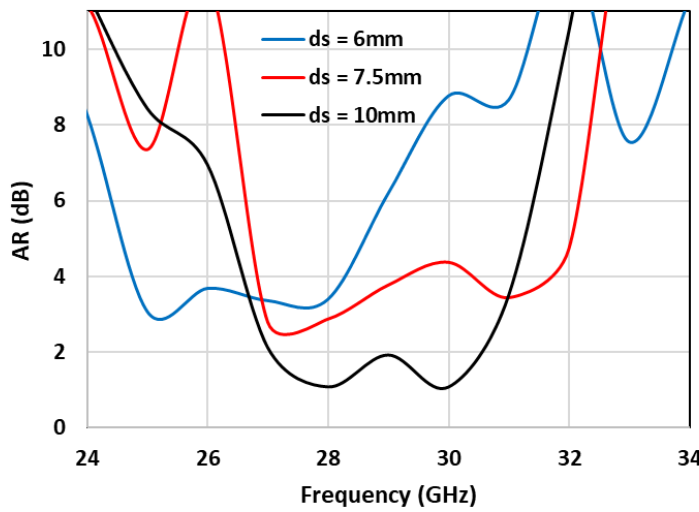
Figure 8. Axial ratio of the DRA array using various separation distances (d s ) between the DRAs.